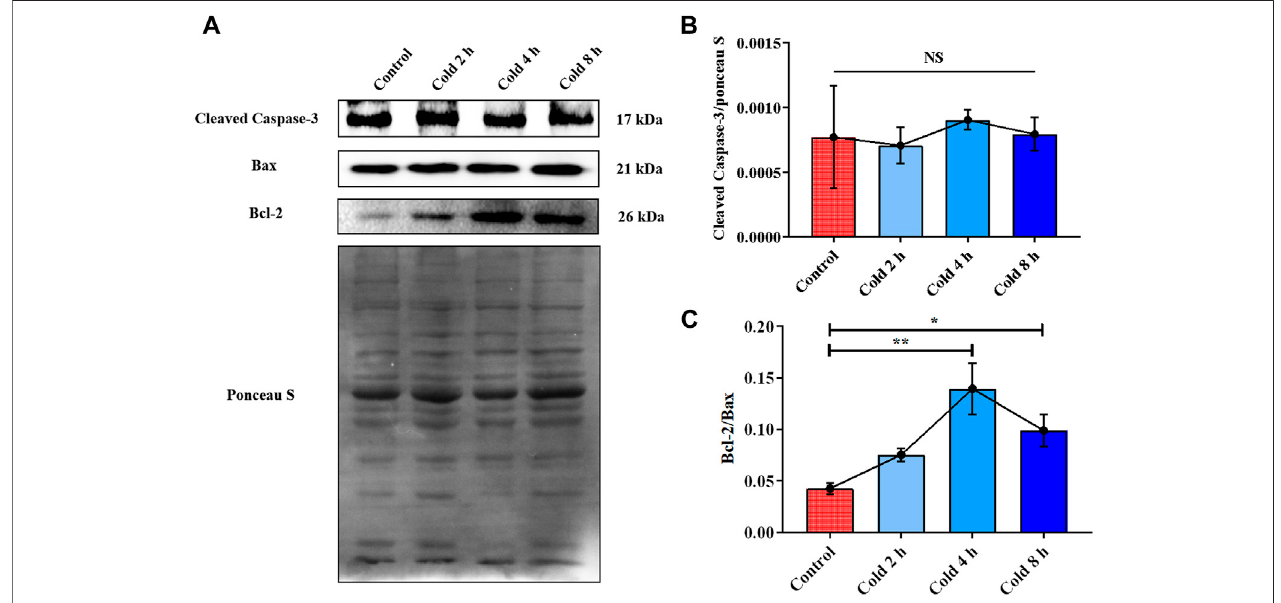
FIGURE 3 | Acute cold exposure induced apoptosis of skeletal muscle in mice. (A) Western blotting results of apoptosis related proteins in mouse skeletal muscle afteracutecoldexposure.TheproteinexpressionlevelsofCleavedCaspase-3 (B) ,theexpressionratioofBaxandBcl-2 (C) intheskeletalmusclesofmice.Thedataare presented as the mean ± SEM (n (cid:1) 8). Statistically signi fi cant differences are indicated; * p < 0.05, ** p < 0.01. Bax, Bcl-2 assaciated x protein; Bcl-2, B-cell